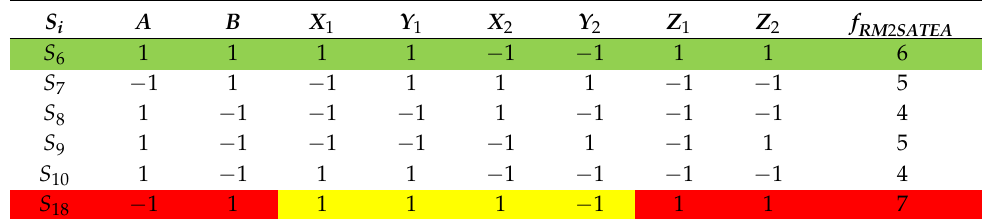
Table A10. S 18 selected as candidate in Party 1.